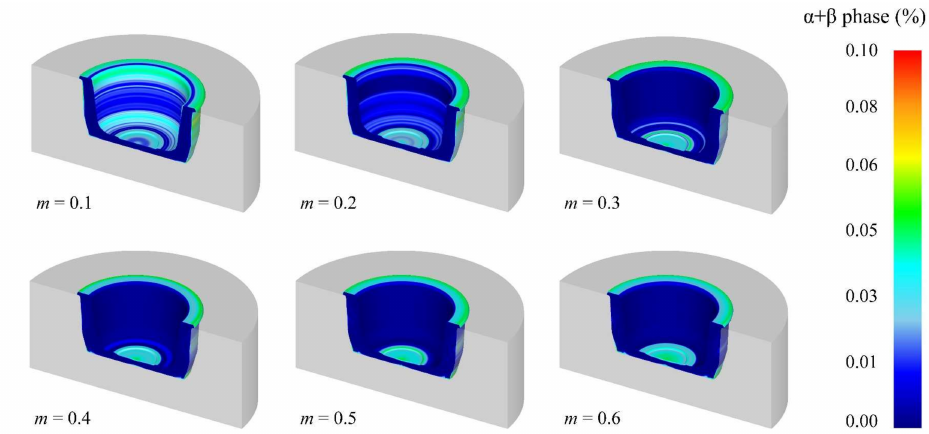
Figure 9. Distributions of α + β phase under various friction